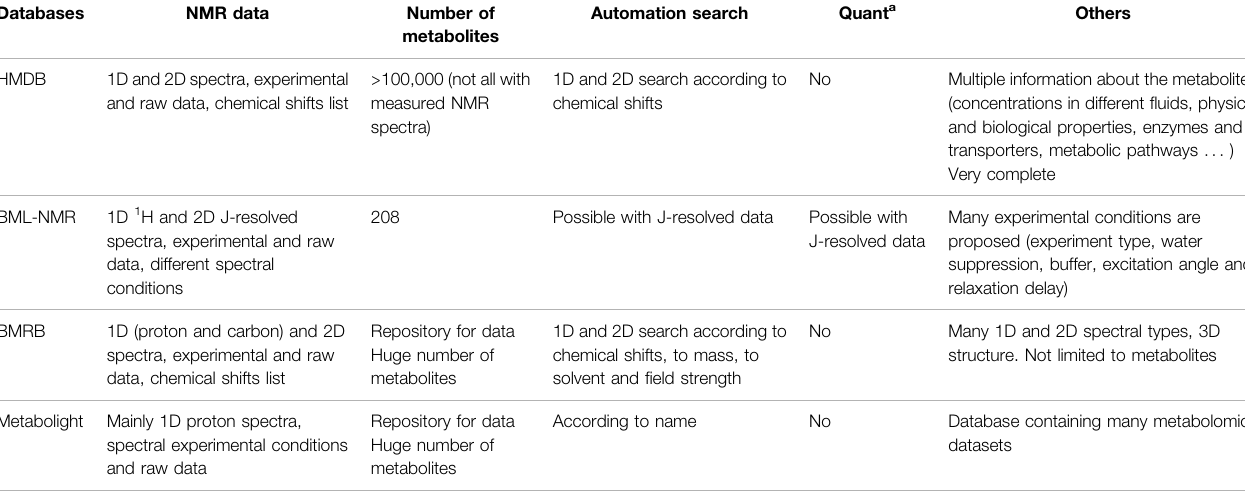
TABLE 1 | The main free access NMR